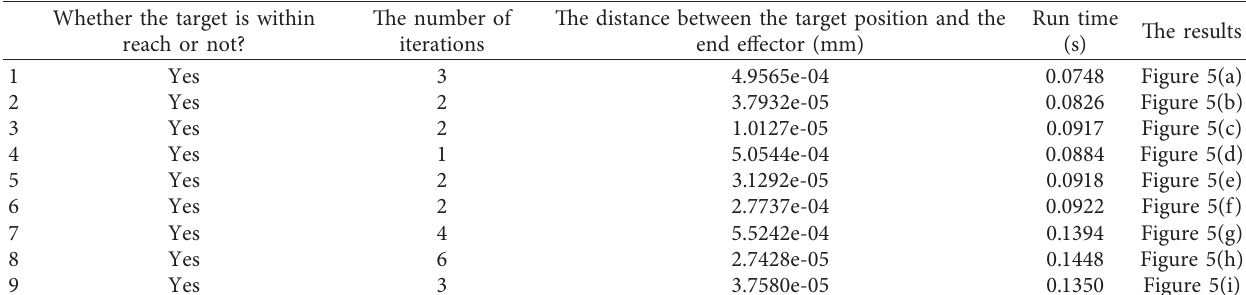
Table 3: The experiment results of extending FABRIK with obstacle avoidance in test